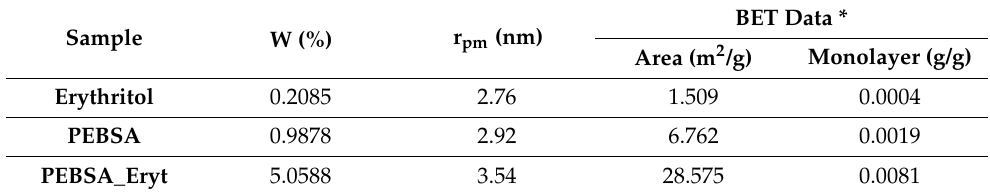
Table 5. Surface parameters evaluated based on adsorption/desorption isotherms: moisture sorption capacity; W, final weight; r pm , average pore size; and BET data. Sample W (%) r pm (nm)